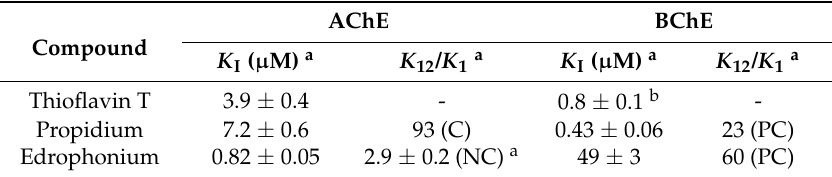
Table 3. Inhibition constants ( K I ) for hAChE and hBChE; binding site competition ratios ( K 12 / K 1 ) for AChE and BChE for each inhibitor in the presence of thioflavin T [23]. A K 12 / K 1 ratio of ~1 indicates no competition at binding sites (NC); high ratios (>100) denote competition at the same binding site (C); and intermediate ratios indicate partial competition